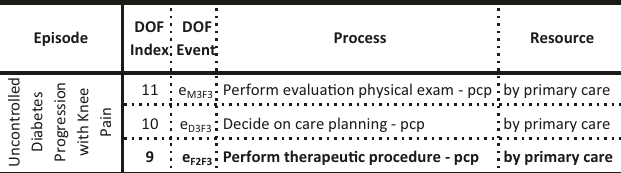
Figure 15: Diabetes Chronic Episode B described in terms of the healthcare delivery system events found in 𝐽 𝐹𝐷𝑀 . The healthcare delivery transformational events are in